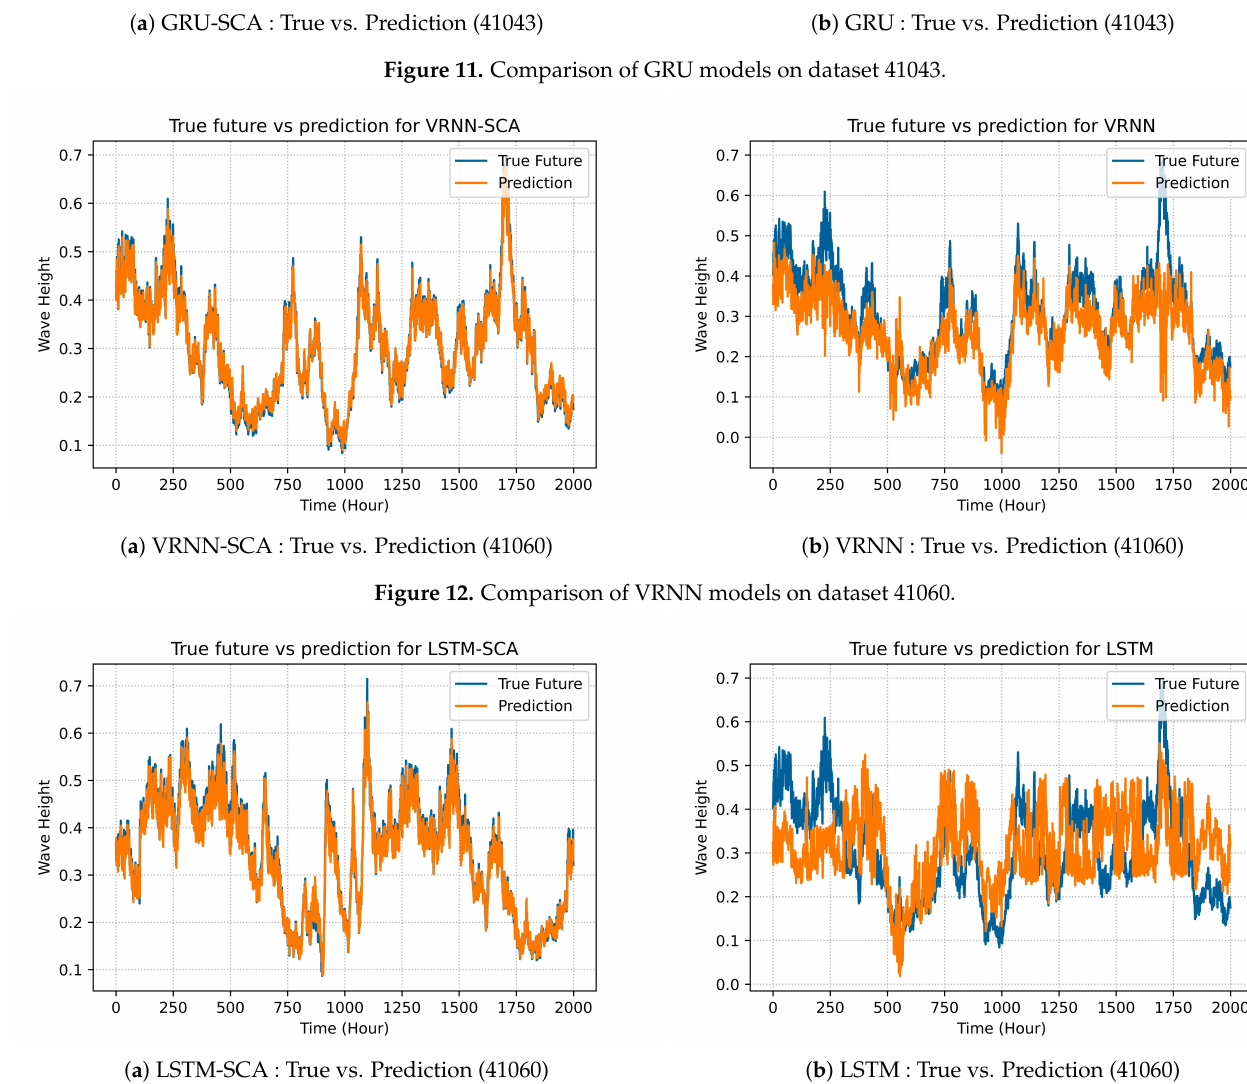
Figure 13. Comparison of LSTM models on dataset